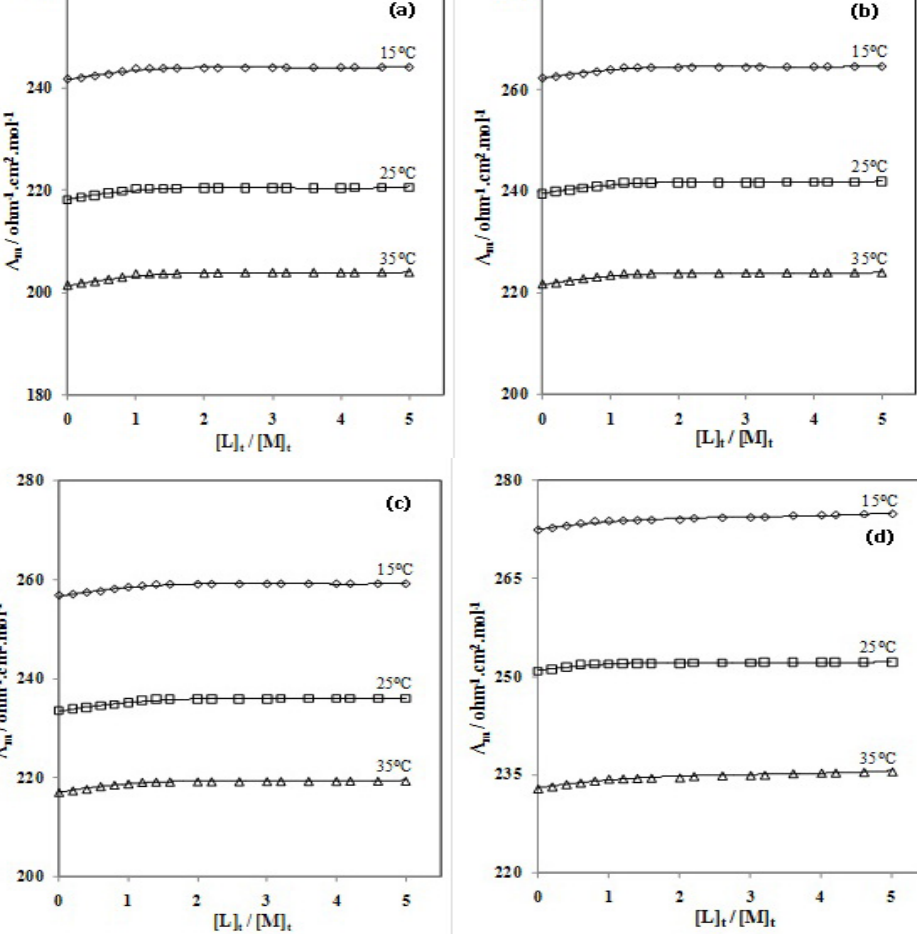
O = ( a ):42.05, ( b ):65.91, ( c ):81.32, ( d ):92.07) at 2